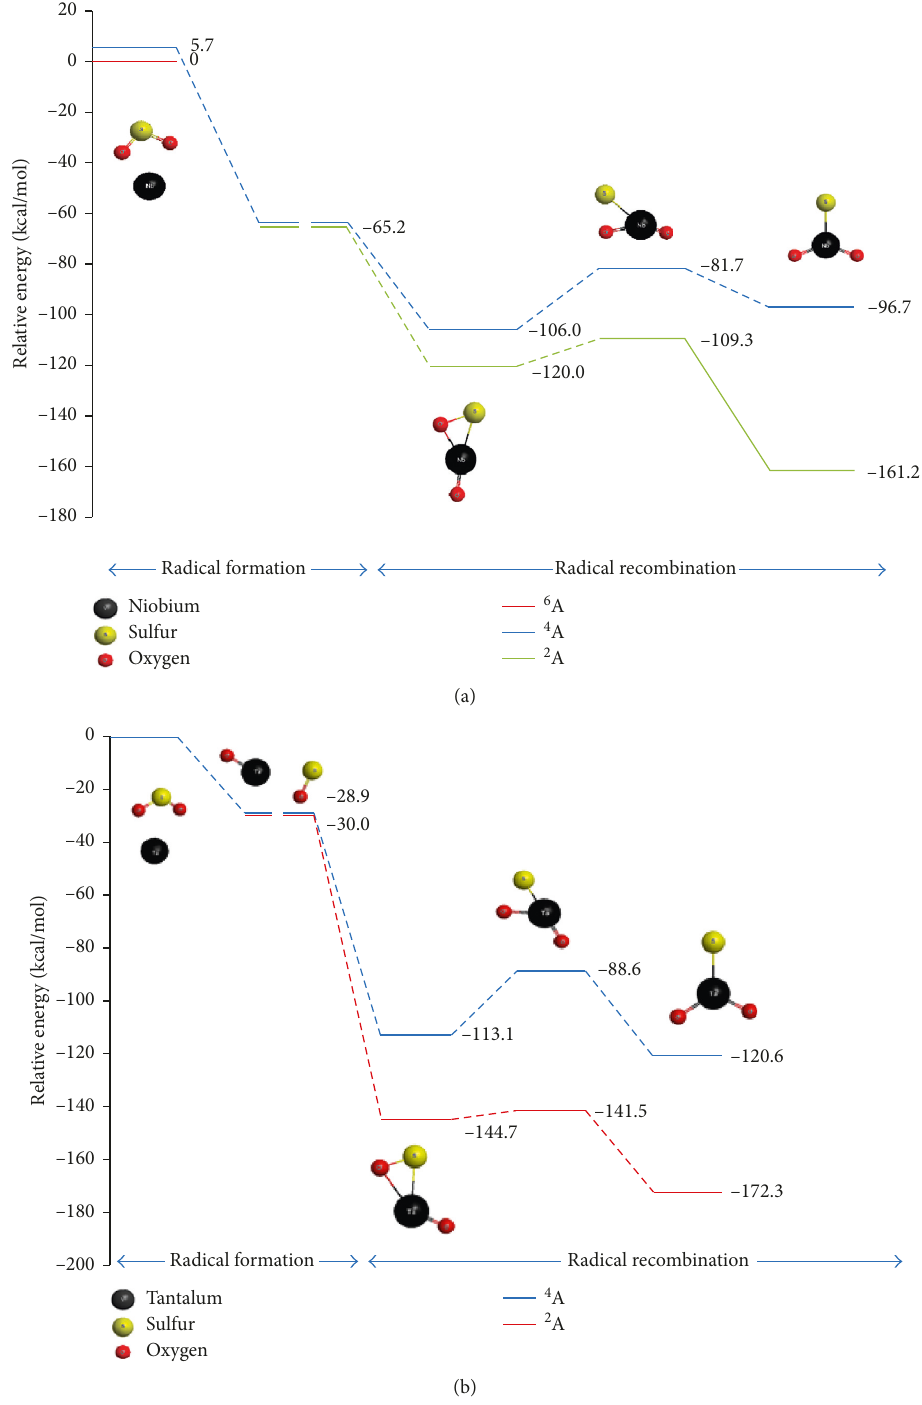
Figure 3: Energy profiles for the Nb +SO